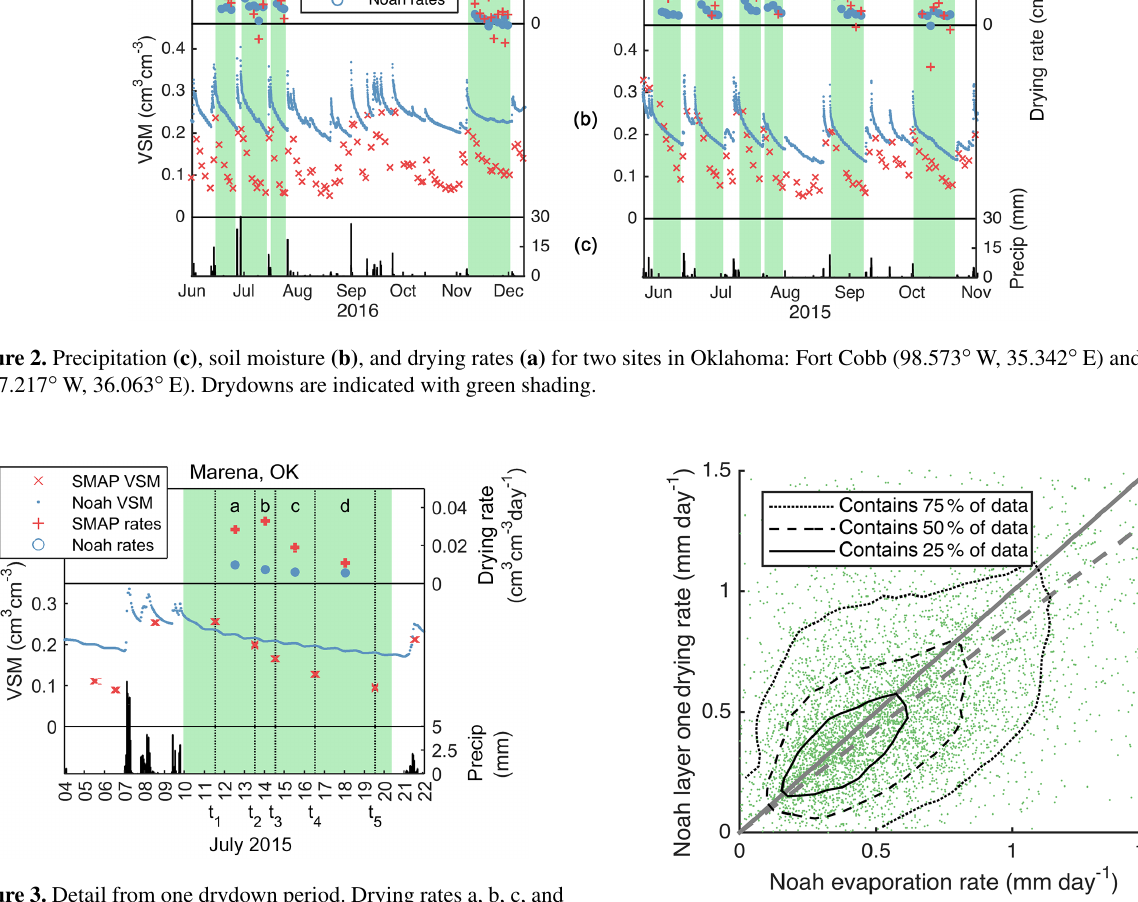
Figure 4. Scatter and contour plot showing correspondence of Noah layer one drying and evaporation rates. Displayed green markers show 0.1% of the 5 + million data points. Contours are drawn using all data. The 1:1 line is shown in solid gray. The best fit line is shown in dashed gray. R =